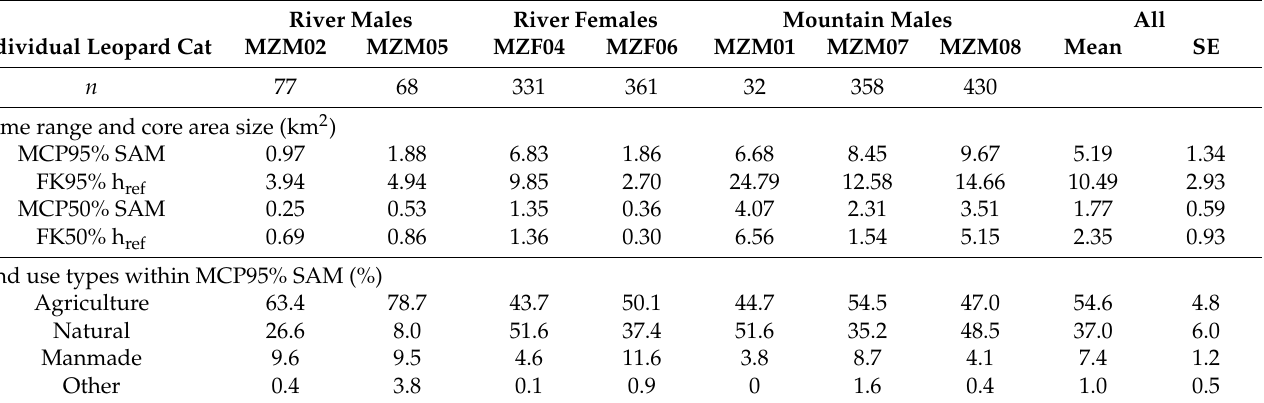
Table 1. Number of daytime locations on which home range calculations were based (excluding the maternal period for the river females), home range and core area sizes in km 2 for individual leopard cats, based on 95% and 50% minimum convex polygons (MCP) with a stationary arithmetic mean (SAM), 95% and 50% fixed kernels (FK) with a reference smoothing parameter (h ref ) and percentage of land use types within the 95%MCPs with